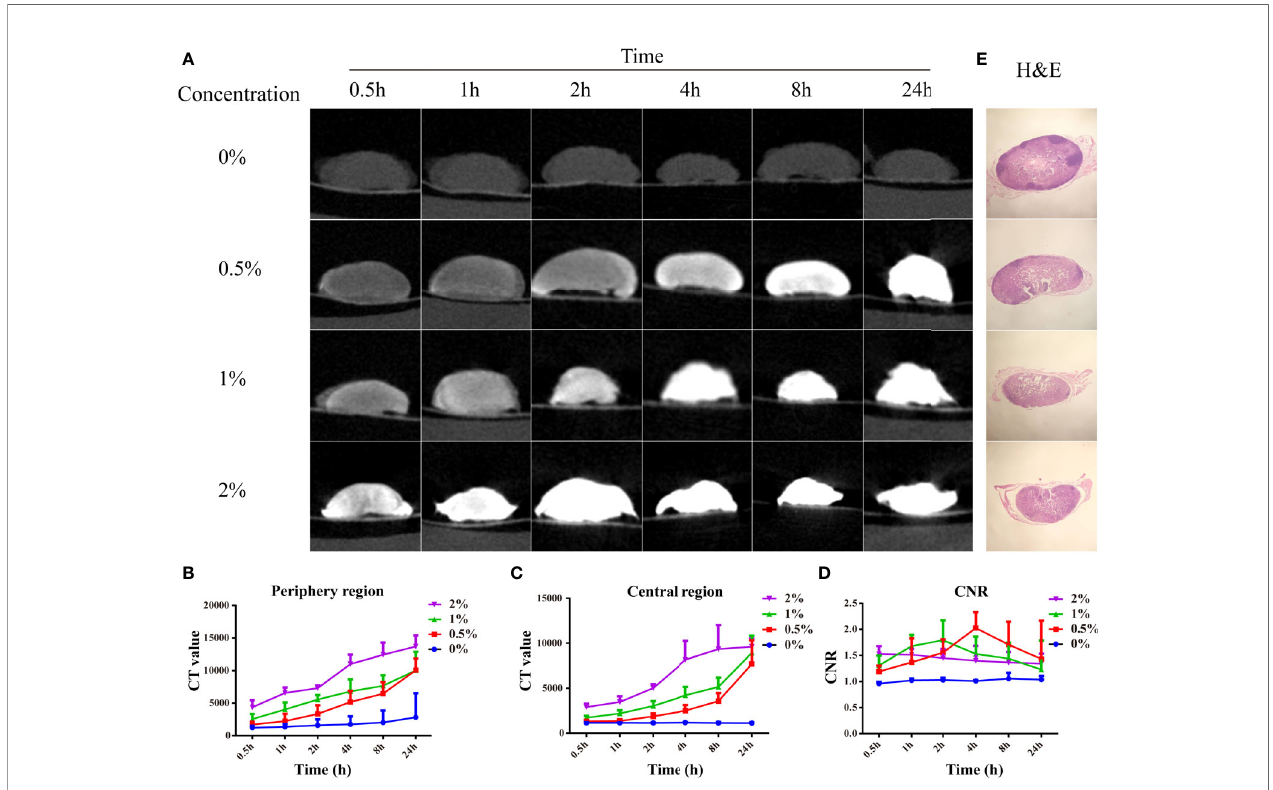
FIGURE 1 | I 2 -IK-enhanced micro-CT imaging for normal LNs from mice. (A) , Micro-CT image of normal LNs stained with different concentration of I 2 -IK for different time. (B, C) , CT value in the periphery region and center region of LNs. (D) CNR of LNs stained with different concentration of I 2 -IK for different times. (E) H&E staining of normal LNs in the different